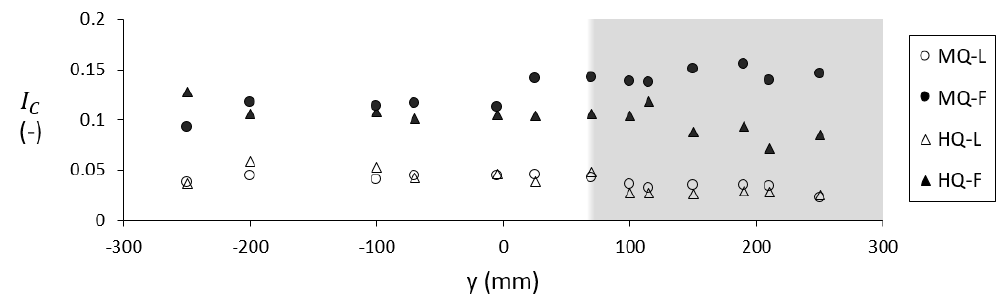
Figure 6. Lateral profiles of the fluctuating component of the suspended sediment concentration, I C , at the investigated lateral cross-section in the fully developed region of the flow. The vegetated part of the cross-section is colored in grey. MQ = medium flow rate (50 L/s); HQ = high flow rate (83 L/s); L = leafless; F = foliated.